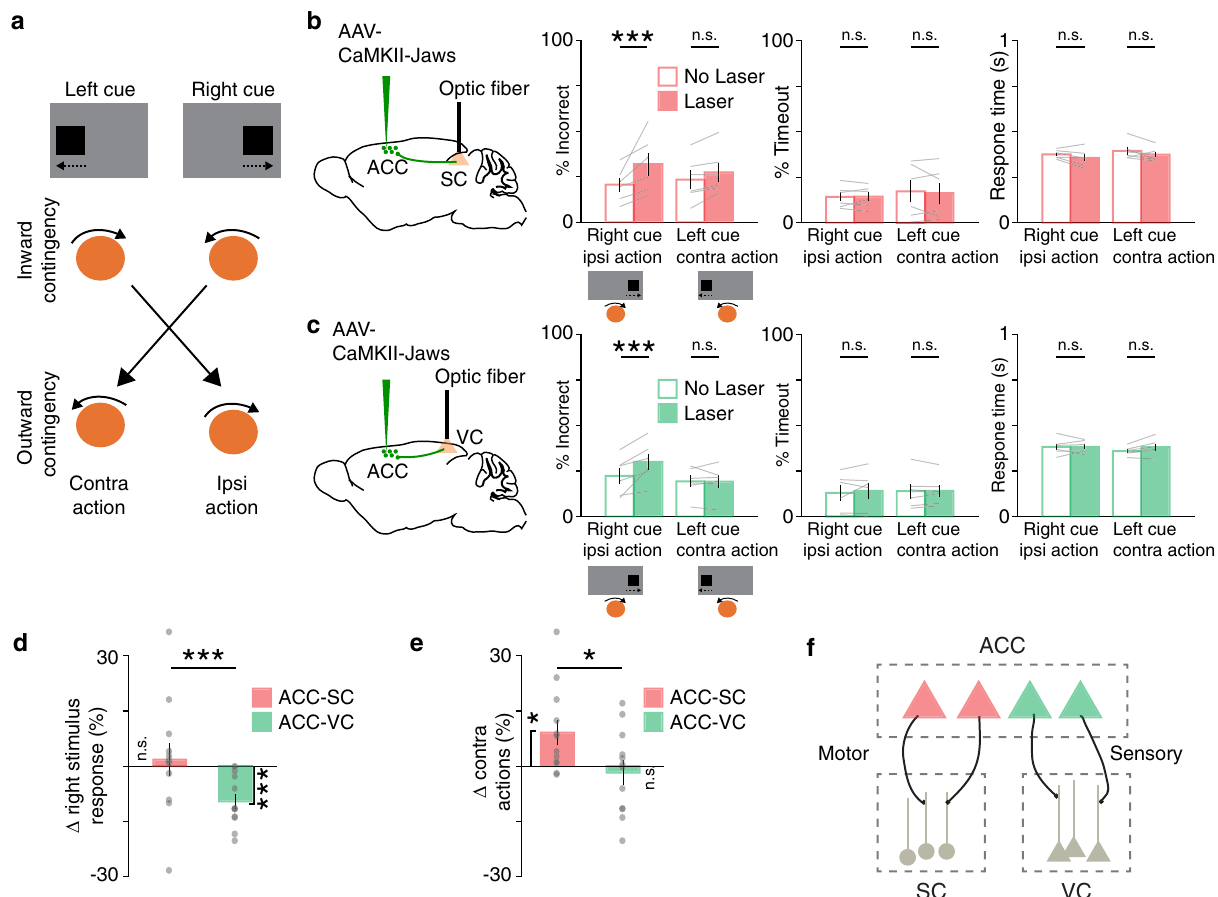
Fig. 6 ACC outputs to SC and VC differentially modulate motor and sensory processing, respectively. a Mice were trained on the outward sensorimotor contingency and were required to move left and right cues to the side of the screen. b Behavioral performance for non-laser (un fi lled) and laser ( fi lled) conditions on right cue/ipsiversive action and left cue/contraversive action trials with inactivation of ACC outputs to the SC in the outward task ( n = 6 mice). Incorrect performance (right cue, p = 0.001; left cue, p = 0.127), timeouts (right cue, p = 0.924; left cue, p = 0.927), and response time (right cue, p = 0.033; left cue, p = 0.138) are shown. *** p < 0.005; n.s. not signi fi cant. Signi fi cance evaluated with two-tailed permutation test at the Bonferroni- adjusted p value of 0.025. c Same as b , except for inactivation of ACC outputs to the VC ( n = 6 mice). Incorrect performance (right cue, p = 0.002; left cue, p = 0.786), timeouts (right cue, p = 0.499; left cue, p = 0.885), and response time (right cue, p = 0.869; left cue, p = 0.042) are shown. Signi fi cance testing same as b . d Data from both tasks was combined. Effect of ACC-SC ( n = 12 mice) and ACC-VC inactivation ( n = 12 mice) on laser-induced